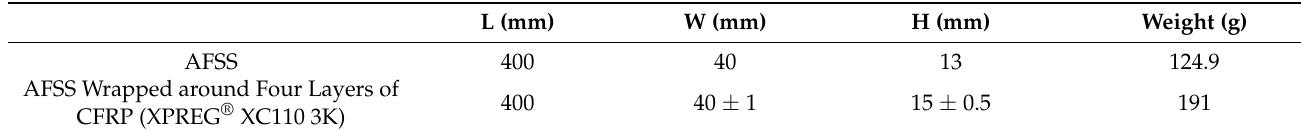
Figure 10. Process and temperature for curing CFRP on the AFFS T. Bending testing was carried out on a DENISON MAYES ® T42B4 universal test ma- chine due the larger loads and sizes of supports required. The larger sized aluminium foam with aluminium skins was carried out under a three-point bending test with the same span ratio as for the smaller standard samples. Table 6 indicates the geometrical parameters used for carrying out the bending tests. The CFRP (XPREG ® XC110 3K) were also wrapped around the closed-cell AFSS to form another form of structure, and sub- jected to a three-point bending test. The size of this new structure is the same as the AFSS (Figure 11A), but the thickness is different (Figure 11B). The span between the two rails was set at 200 mm. Table 6. Geometrical properties for bending tests large scale.